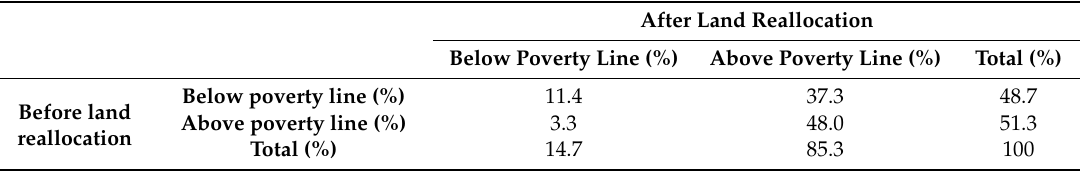
Table 5. Poverty changes resulting from reallocation of plantation land to reflect family size within the Plantation